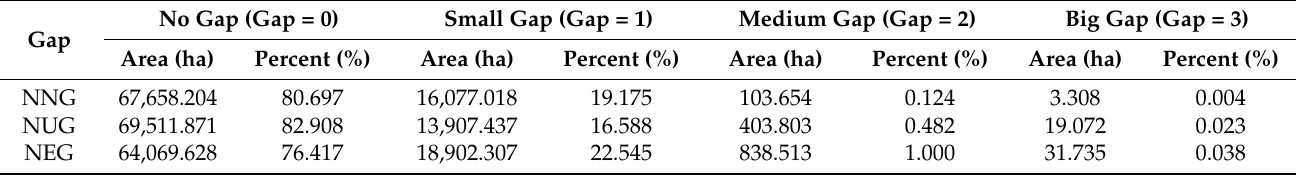
Figure 8. Gap in the quality of cultivated land grade: (a) NNG gap, (b) NUG gap, and (c) NEG gap. Table 4. Area and percentage of cultivated land quality grade